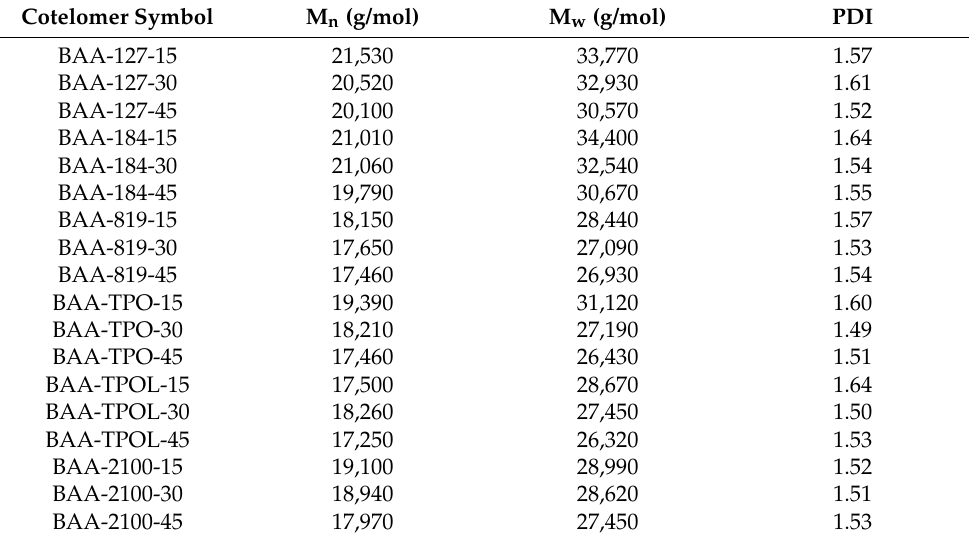
Table 3. Molecular weights and polydispersity of